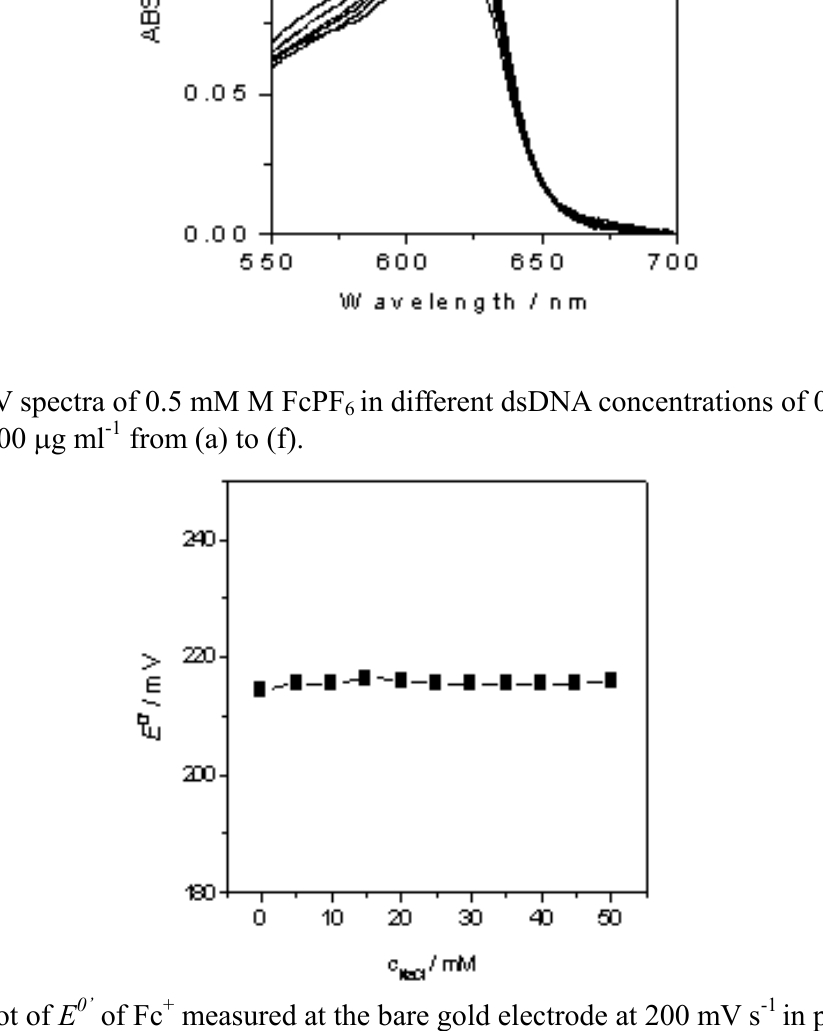
Figure 6. Plot of E 0’ of Fc + measured at the bare gold electrode at 200 mV s -1 in presence of 0.5 mg ml -1 dsDNA vs c NaCl